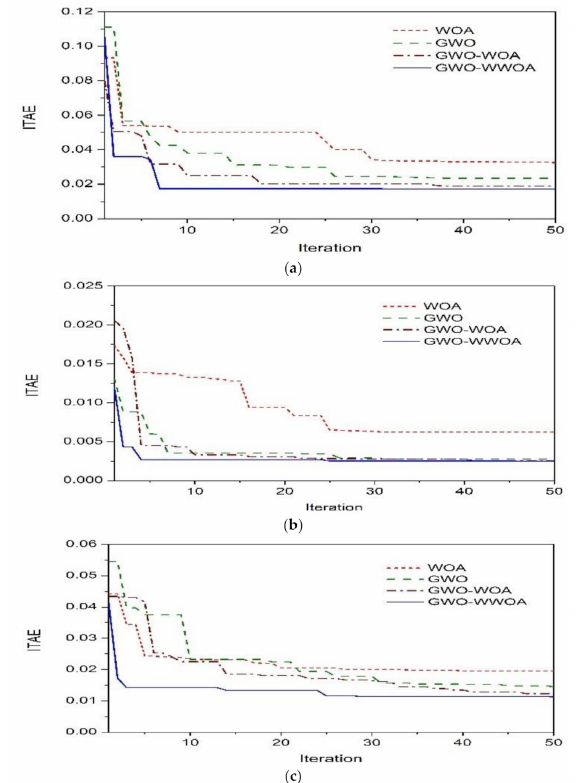
Figure 4. The ITAE values for each joint obtained from WOA, GWO, and GWO-WOA, and WWOA techniques. ( a ) link 1. ( b ) link 2. ( c ) link